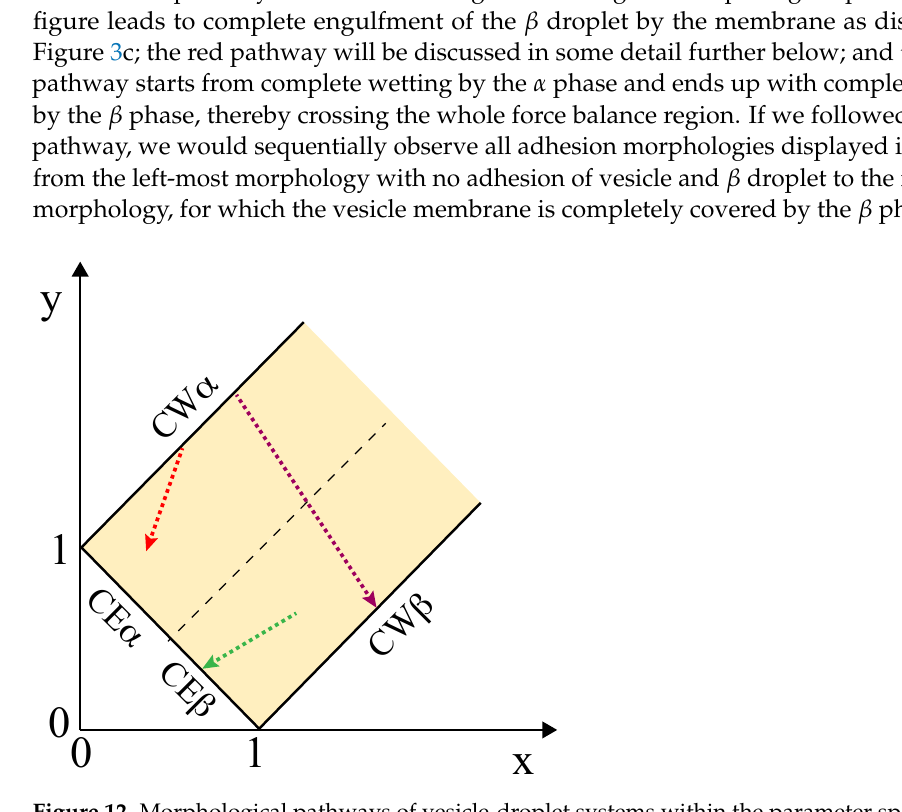
Figure 12. Morphological pathways of vesicle-droplet systems within the parameter space defined by the tension ratios x = Σ m αγ / Σ αβ and y = Σ m / Σ αβ as in Figure 11. The green pathway starts from βγ partial wetting of the vesicle membrane by a β droplet and ends up with the complete engulfment of this droplet as in Figure 3c. The red pathway starts from complete wetting of the vesicle membrane by the α phase and then undergoes a complete-to-partial wetting transition, see the example in the next subsection. The purple pathway starts from complete wetting by the α phase and ends up with complete wetting by the β phase. For visual clarity, the different pathways have been drawn as straight lines but can, in general, be arbitrarily